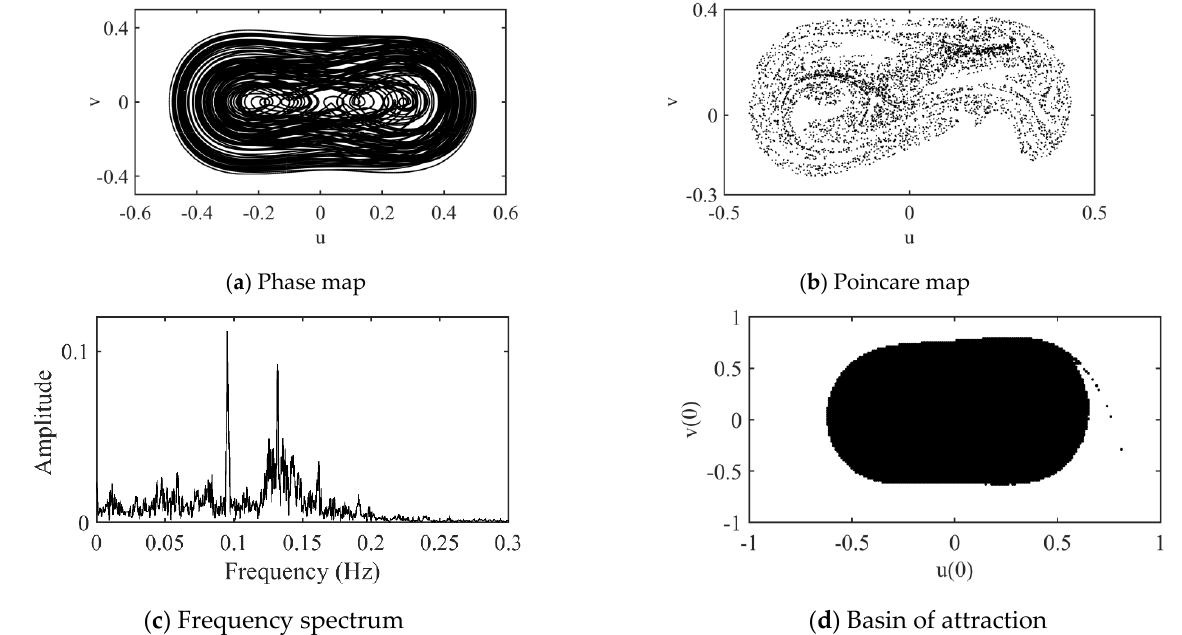
Figure 8. Attractor and its basin of attraction when V AC = 0.28.